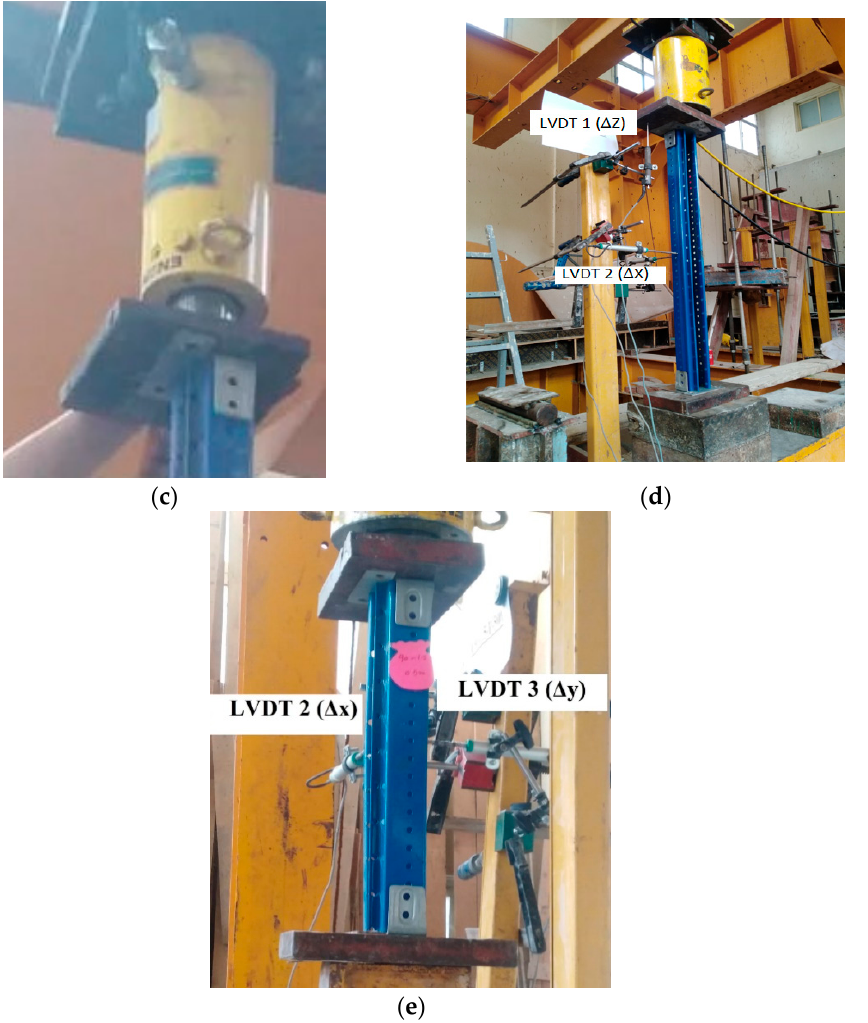
Figure 3. Test setup and instrumentations. ( a ) Setup of the used hinge base, where it was connected to the specimen using one bolt only; ( b ) Setup of a hinge at the top of the specimen; ( c ) Setup of a hinge at the bottom of the specimen; ( d ) Positions of LVDT2 and LVDT3; ( e ) Position of LVDT1.